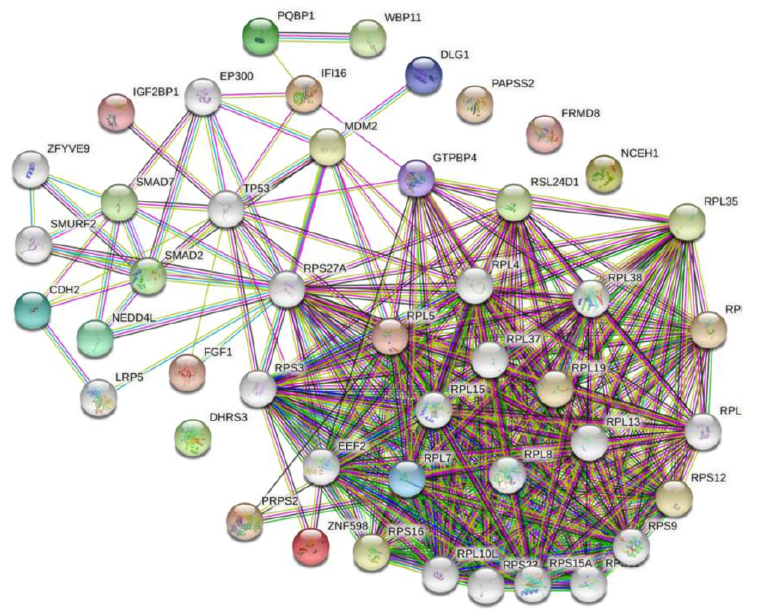
Figure 3. The network of cellular proteins. The network of host proteins interacting with ARV